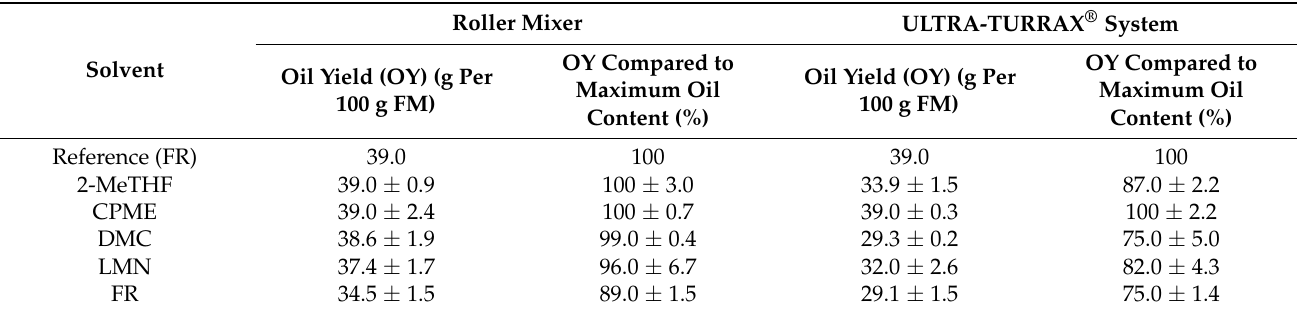
Table 2. Monkfish liver oil extraction with four green solvents and a conventional solvent (reference solvent) using two blending systems (mean ± standard deviations, n =